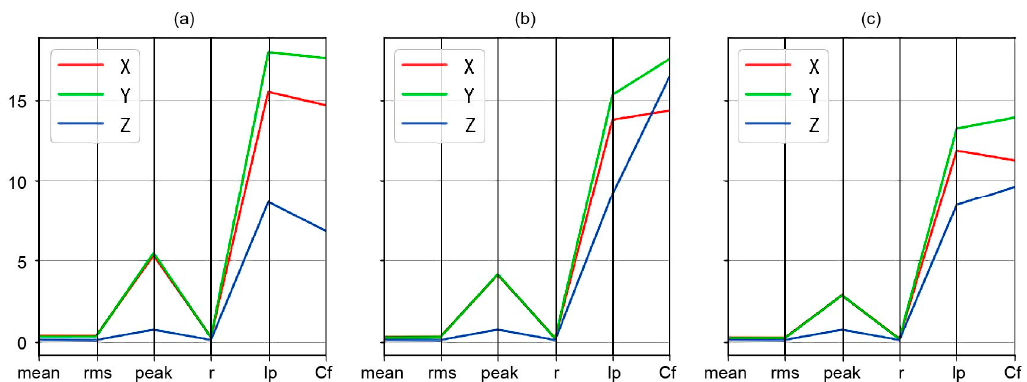
Figure 2. Comparison of characteristic variables of vibration in the time-domain. (a) Fine Gravel, Sandstone, Sandstone, ( b ) Fine Sandstone, ( c ) Mudstone. (b) Fine Sandstone, (c) Mudstone.